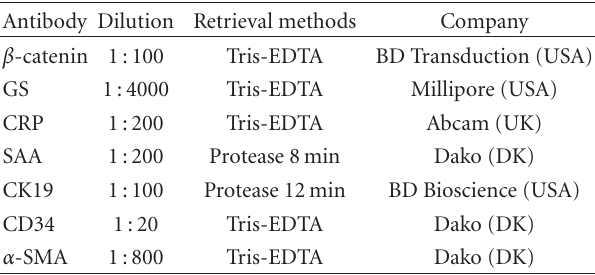
Table 1: Antibodies applied for immunohistology. Antibody Dilution Retrieval